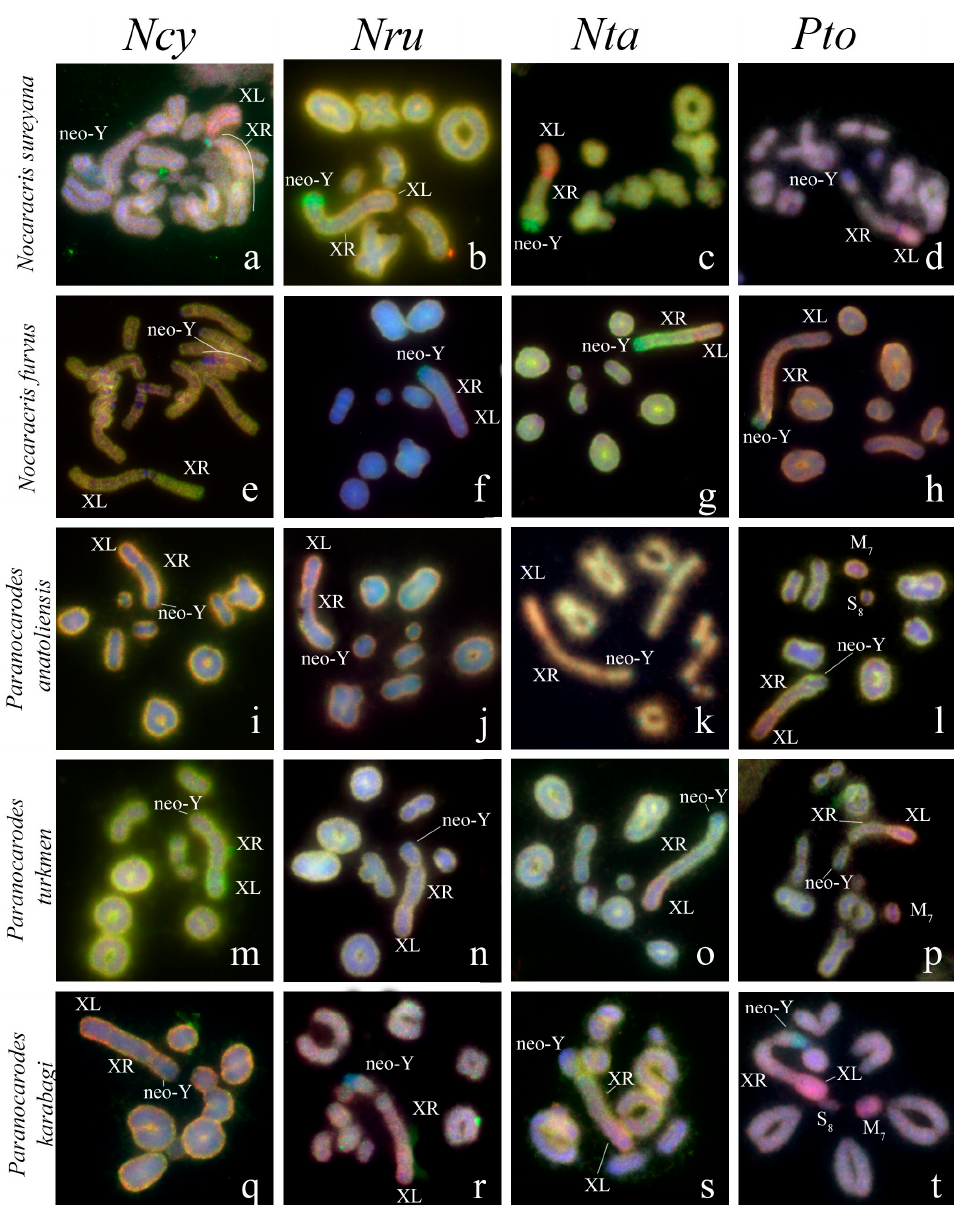
Figure 4. FISH of microdissected DNA probes with meiotic chromosomes of Nocarodeini species: the XL DNA probes (red) and the neo-Y DNA probes (green). XL indicates short arm of neo-X that corresponds to ancestral X chromosome, XR indicates long arm of neo-X chromosome derived from autosome fusion. Neo-Y indicates corresponding chromosome Names of species indicated in rows and name of probes indicated in columns. ( a – d ) Nocaracris sureyana ; ( e – h ) Nocaracris furvus ; ( i – l ) Paranocarodes anatoliensis anatoliensis; ( m – p ) Paranocarodes turkmen ; ( q – t ) Paranocarodes karabagi ; ( a,c,e,g ) Intensive FISH signals from neo sex chromosome probes can be observed in C-positive regions of autosomes.